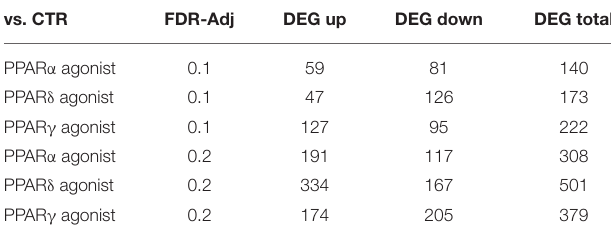
TABLE 1 | List of differentially expressed genes in PCLS for the three comparisons of interest. vs.